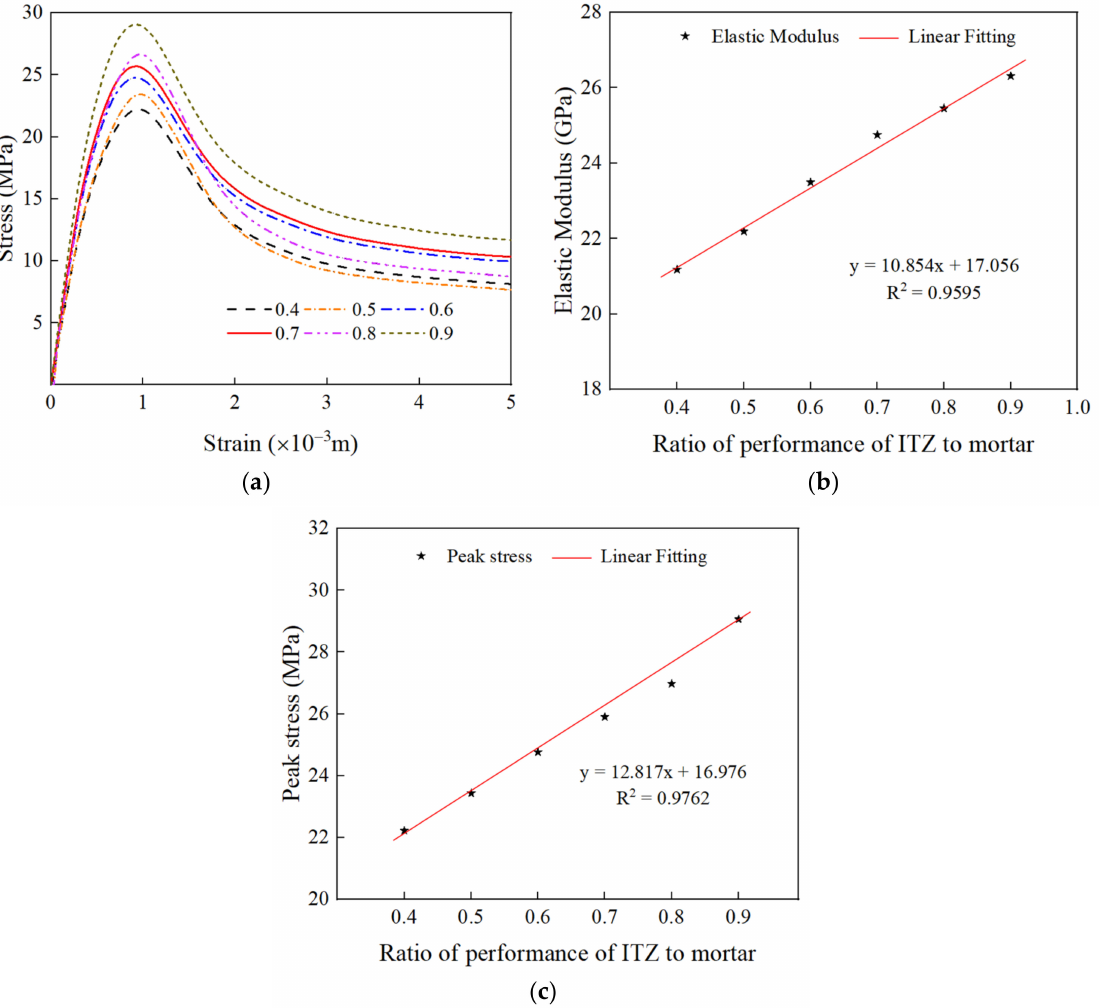
Figure 14. The effect of the strength of ITZ on the stress–strain curve of RAC under uniaxial compression. ( a ) Stress–strain curve; ( b ) linear fitting of elastic modulus; ( c ) linear fitting of peak compressive